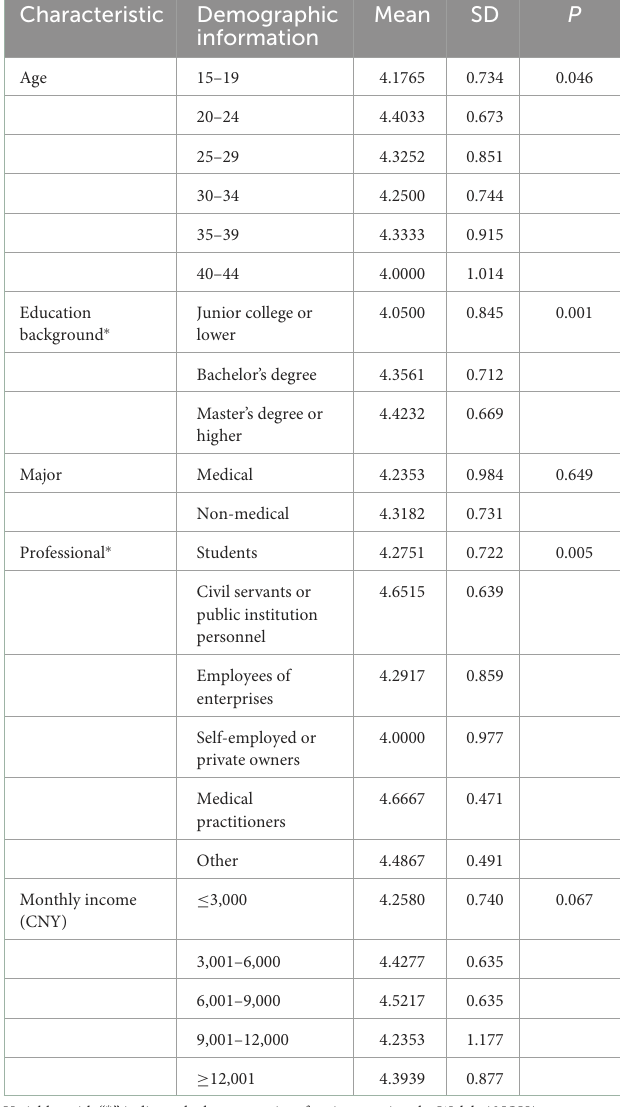
TABLE 1 Demographic characteristics of the participants ( N = 567). Characteristic